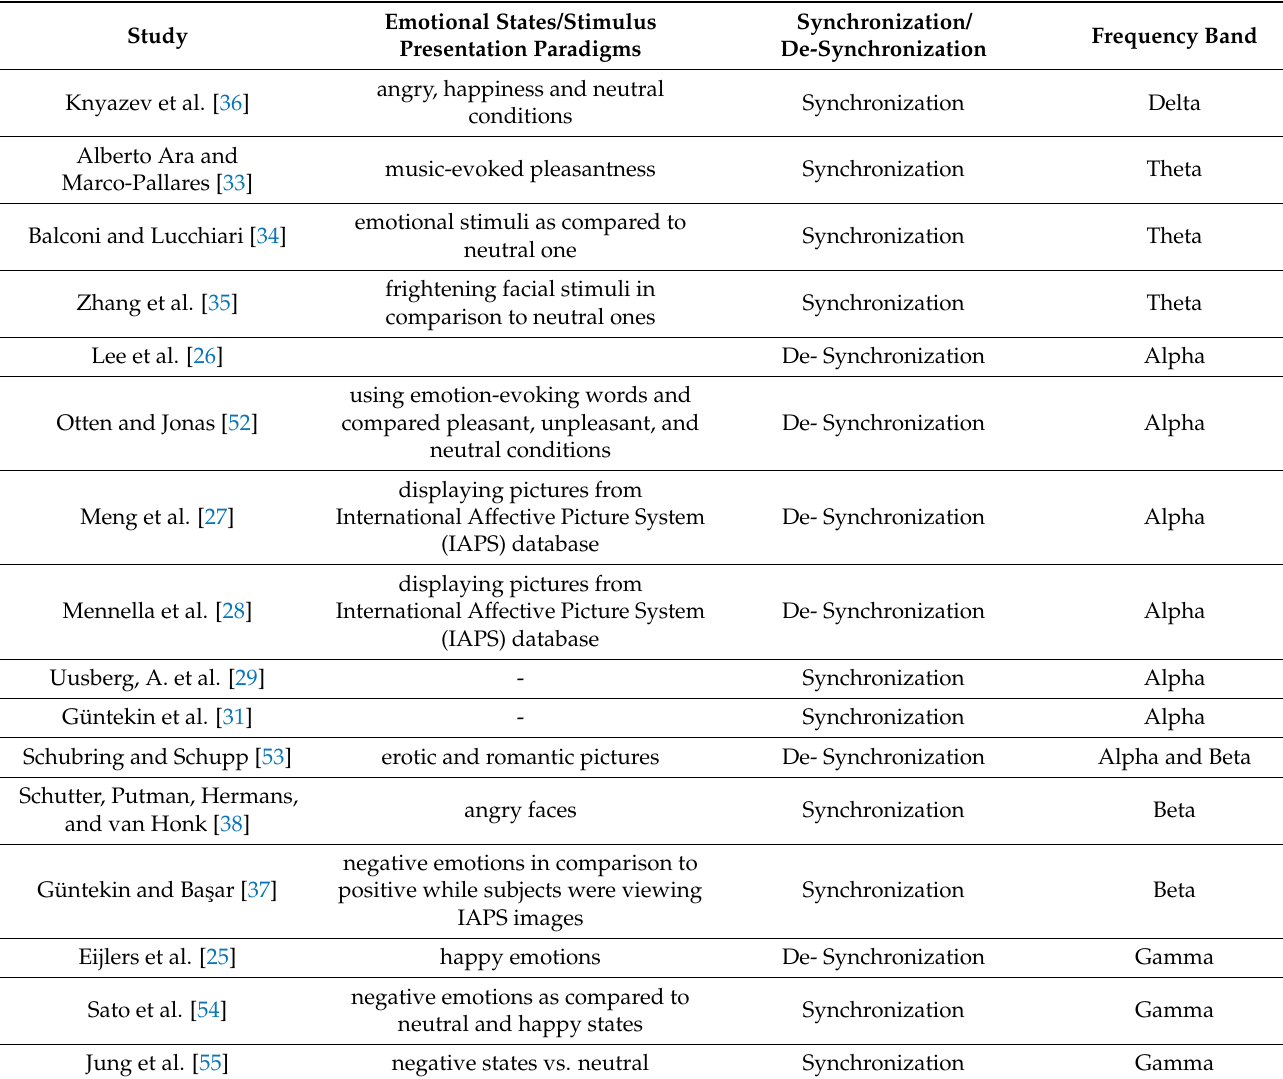
Table 1. List of EEG-based studies for emotion recognition identifying synchronization/de-synchronization in different spectral